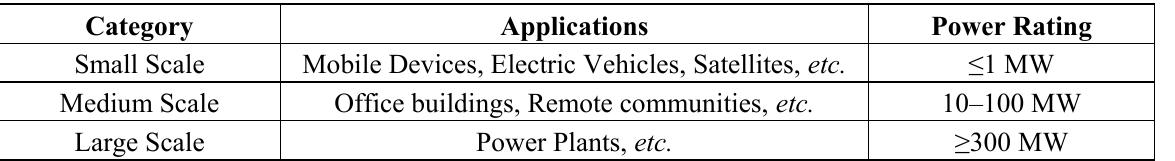
Table 1. A categorization of scales of energy storage and their